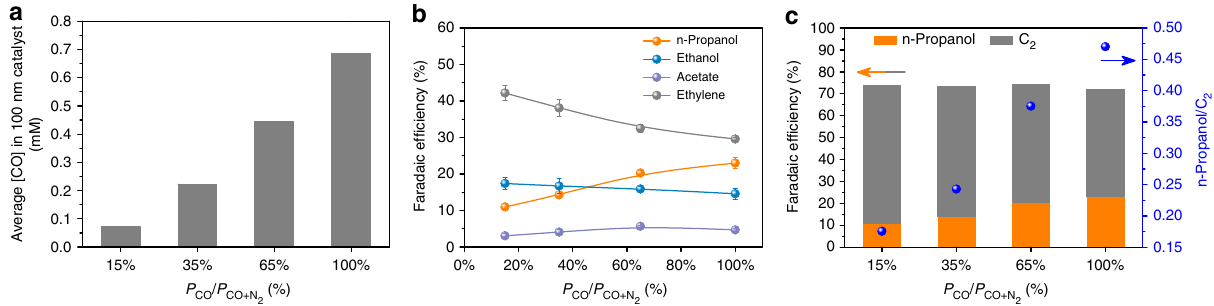
Fig. 5 CO partial pressure analysis of n-propanol production. a Modeling of the average [CO] in 100 nm catalyst at 30 mA cm − 2 over the change of CO partial pressure in 1 M KOH; the similar current density was achieved experimentally with an applied potential of − 0.44 V vs. RHE. b CO partial pressure- dependent test on Cu adparticle electrocatalysts at − 0.44 V vs. RHE in 1 M KOH. c The FE n-propanol /FEC 2 ratio of Cu adparticle electrocatalysts obtained on different CO partial pressure at − 0.44 V vs. RHE in 1 M